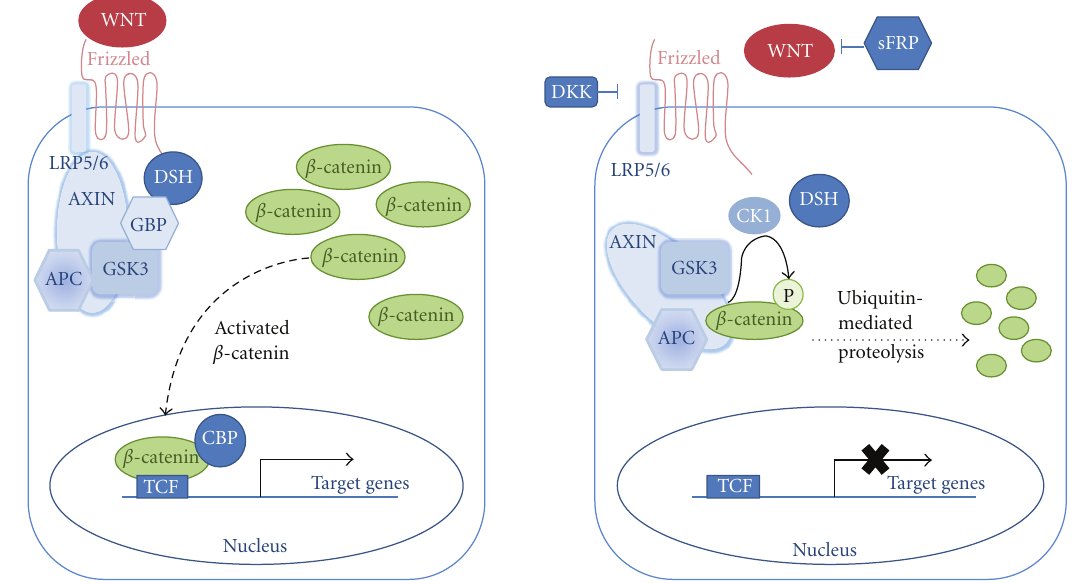
Figure 1: Model of the WNT/APC/beta-catenin pathway (Adapted from Moon et al.